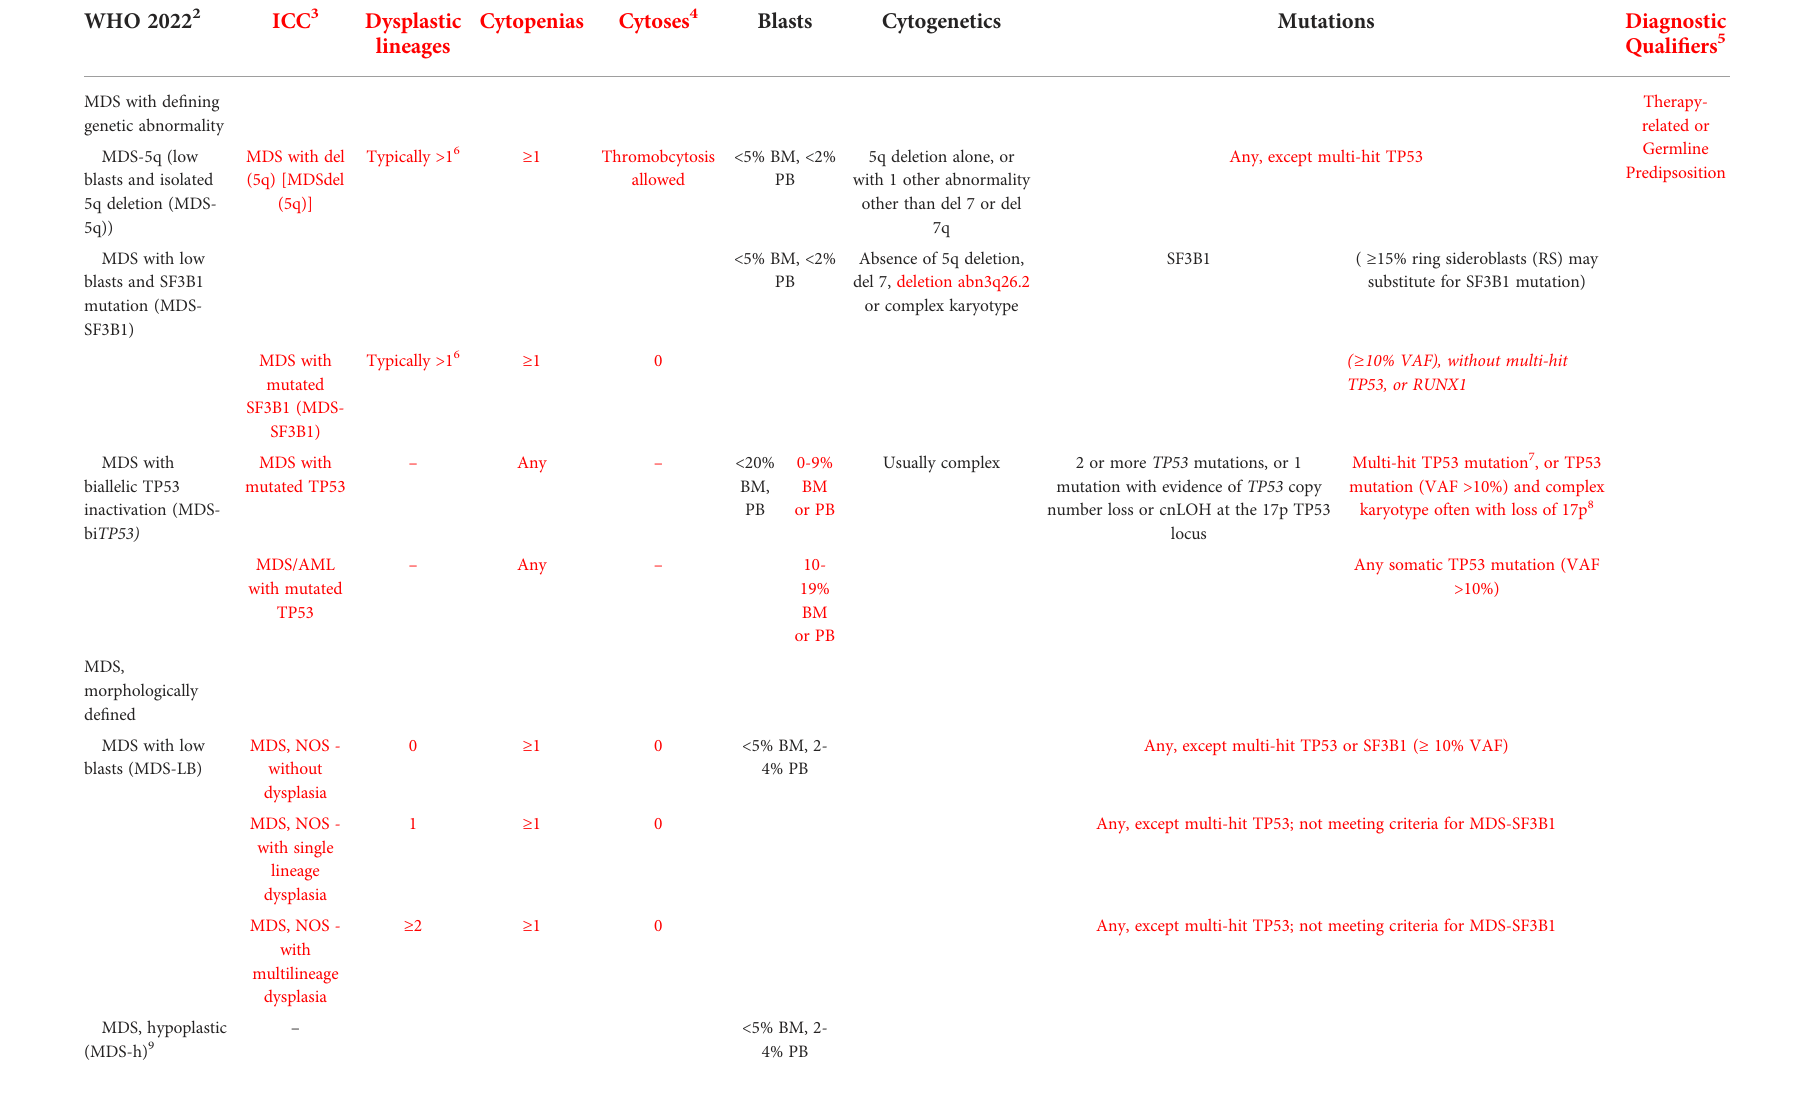
TABLE 1 A comparison of the WHO and ICC classi fi cation systems for MDS. Criteria speci fi c to the ICC classi fi cation system are color coded red. Classi fi cation of Myelodysplastic Neoplasms (MDS) 1,2,3